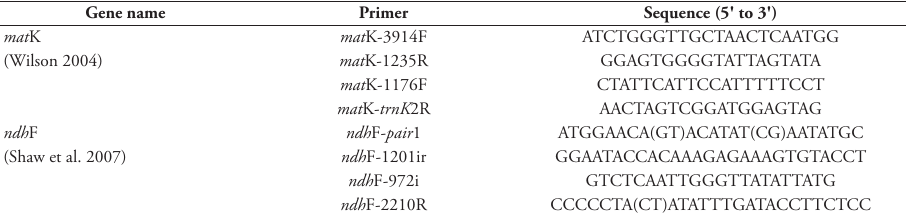
Note: n, sample number. Table 2. Primers used in this study. Gene